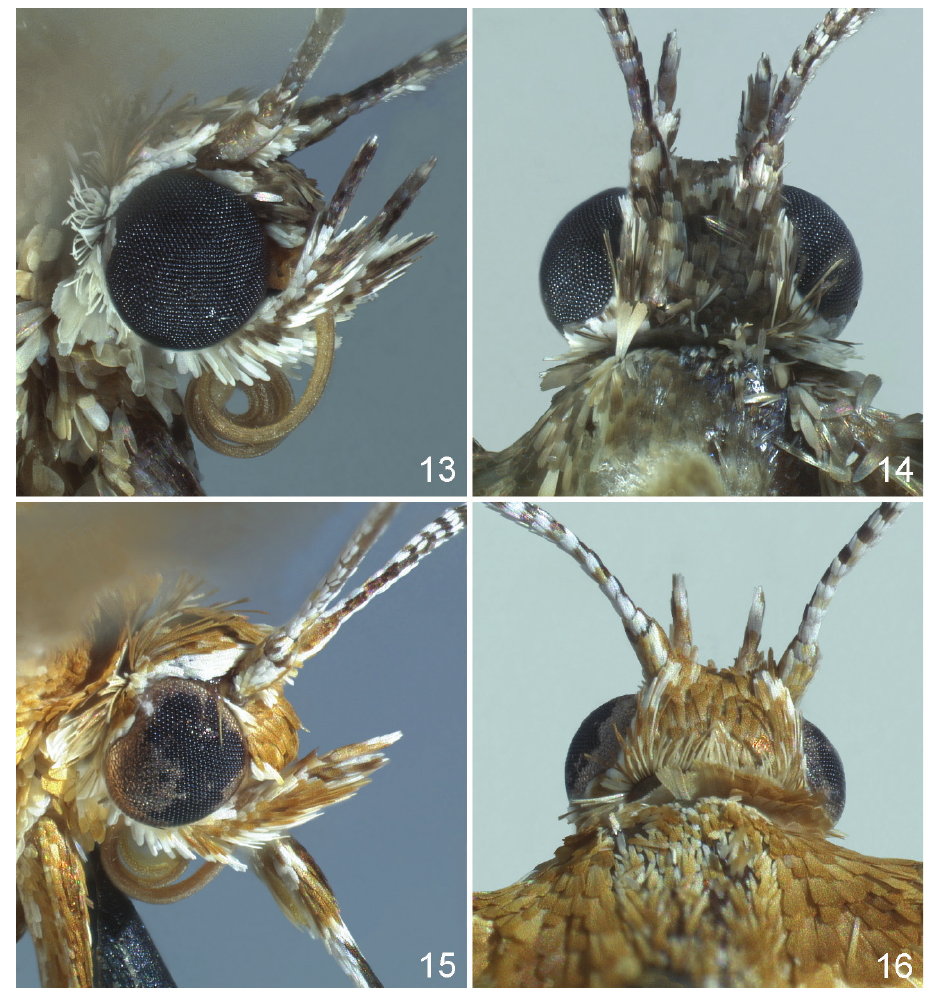
Figures 13–16. Close up of Oxyptilus heads: 13 lateral view of O. eleanerae , holotype 14 dorsal view of holotype 15 lateral view of O. delawaricus (same specimen as figure 10) 16 dorsal view of same